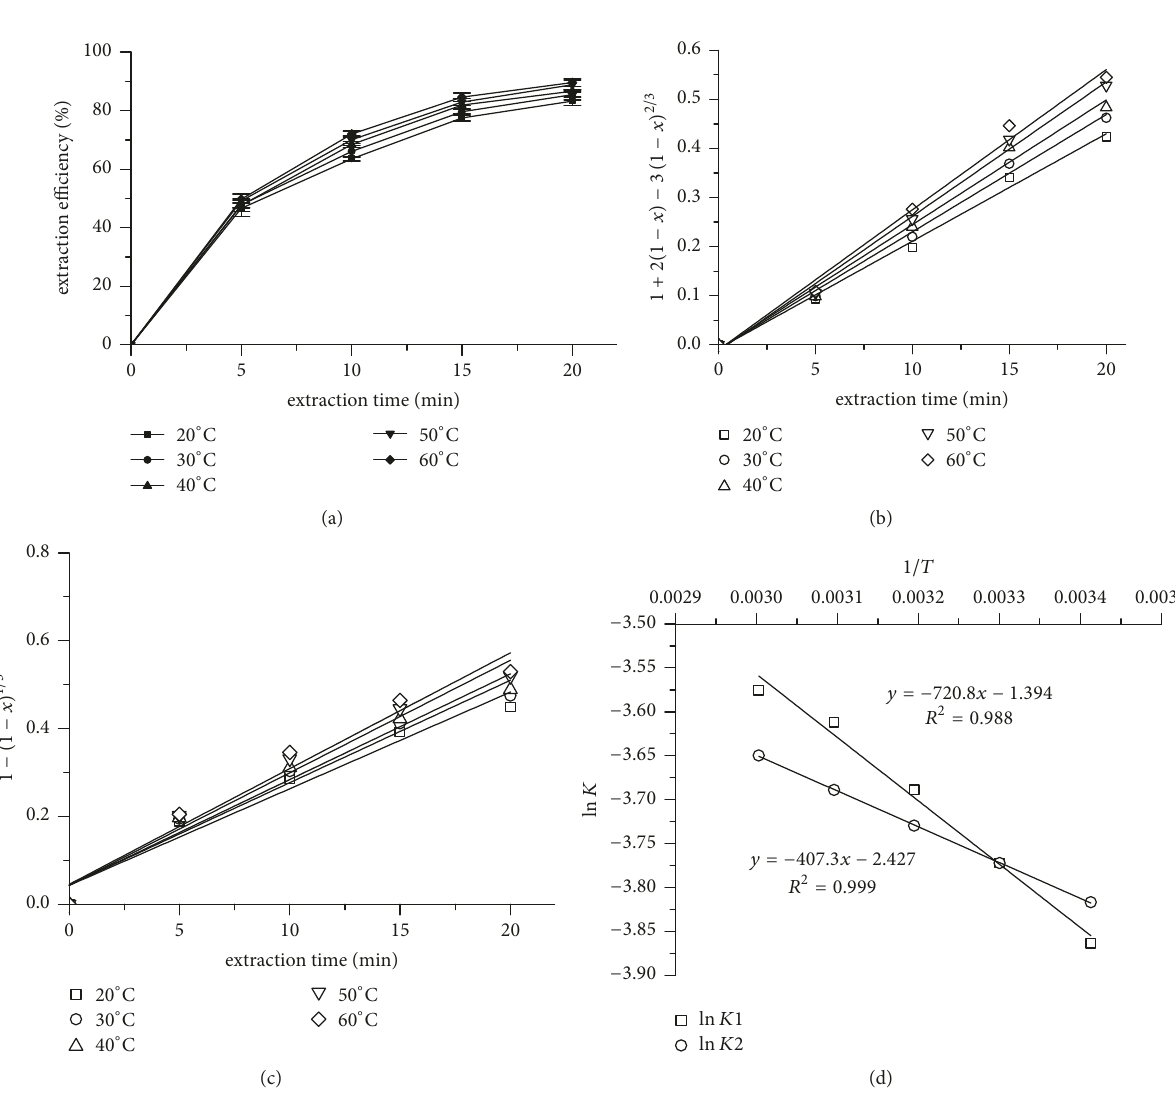
Figure 3: The extraction kinetic curves of SPI by AOT reverse micelle: (a) effect of temperature to the extraction efficiency; (b) the extraction kinetic curve by equation 1 + 2(1 − 𝑥) − 3(1 − 𝑥) 2/3 = 𝐾 1 𝑡 ; (c) the extraction kinetic curve by equation 1 − (1 − 𝑥) 1/3 = 𝐾 2 𝑡 ; (d) the apparent activation energy curve of SPI extraction by AOT reverse